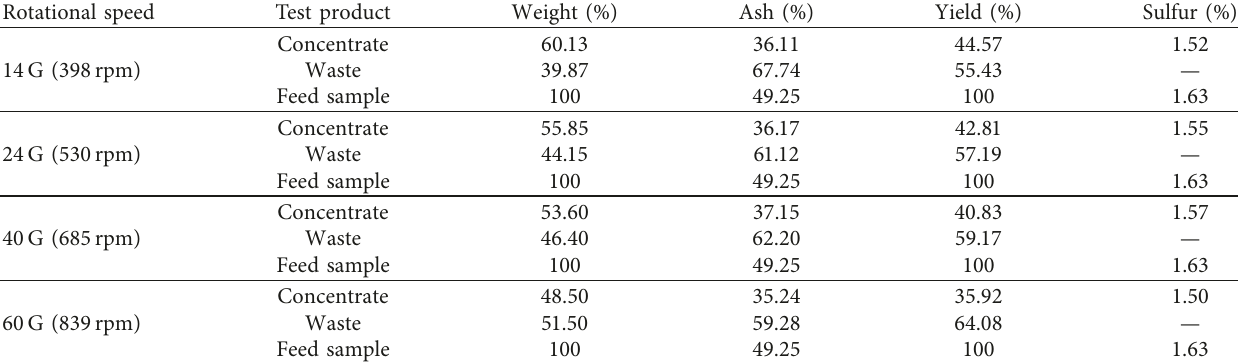
Table 12: Enrichment concentration values of Sample-C2 coal with Knelson method (